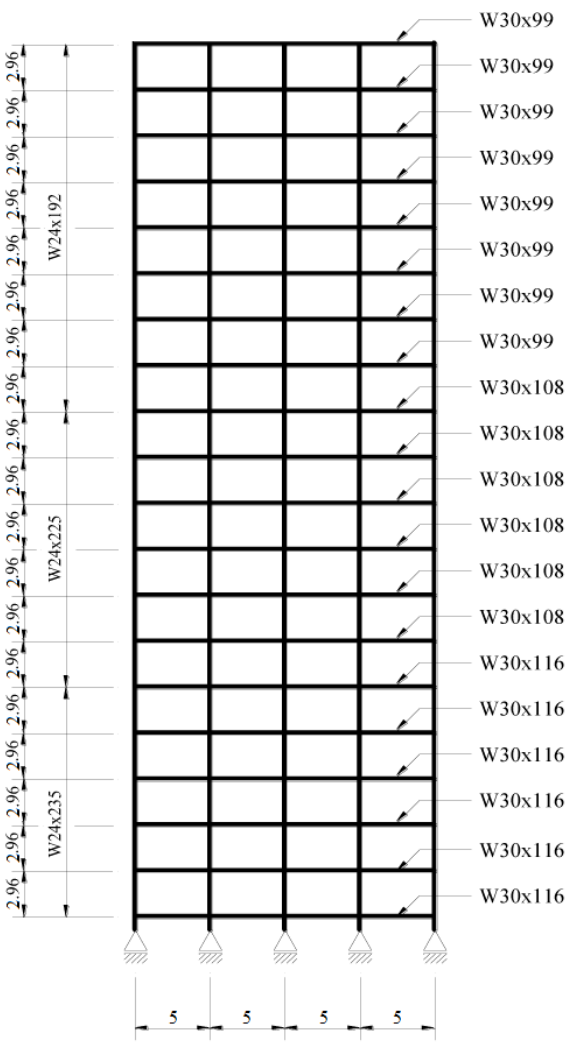
Figure 1: Studied 20-story steel structure.